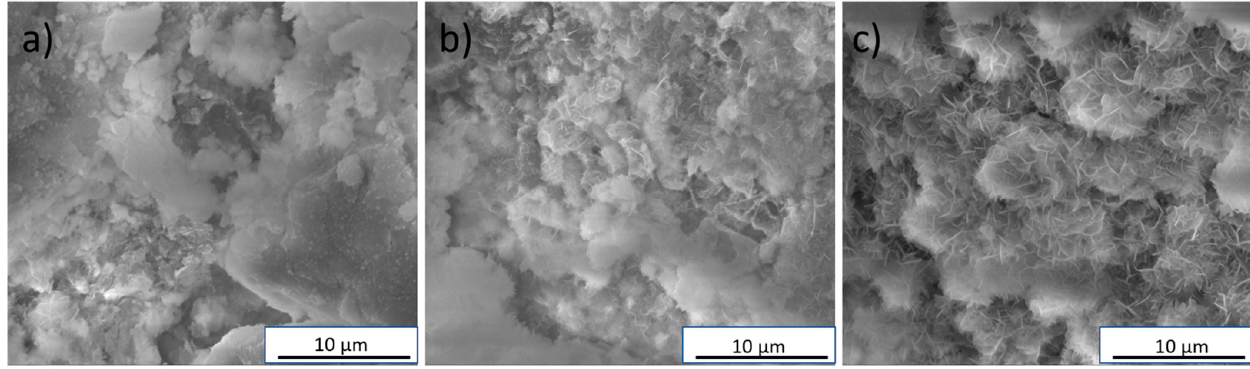
Figure 6. SEM microphotographs of the following materials: ( a ) HT, ( b ) Au-HT, and ( c ) Au, Si-HT after 7 days of incubation in SBF.